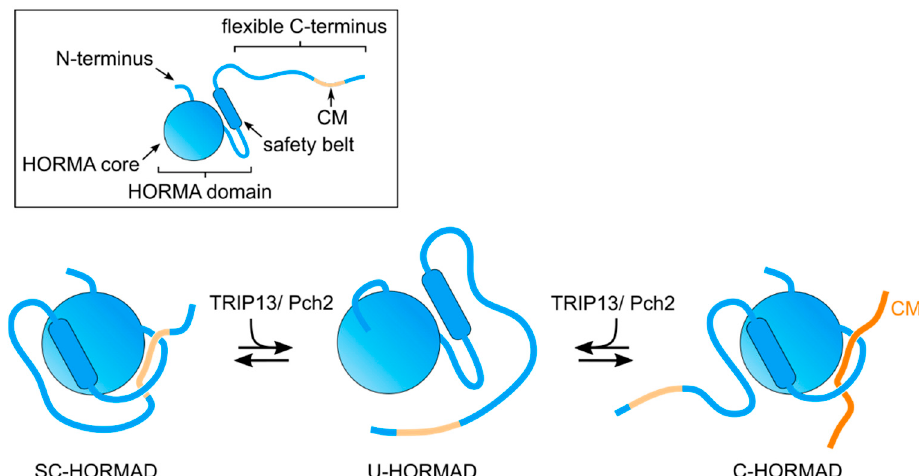
Figure 3. Graphical representation of possible meiotic HORMAD conformations, mediated by Pch2/TRIP13: SC (self-closed)-HORMAD; U(unbuckled)-HORMAD; and C(closed)-HORMAD bound to a CM motif on an interactor, such as an axis component. We note that, in addition to the HORMAD binding to its own CM in cis, a trans conformation is also possible.